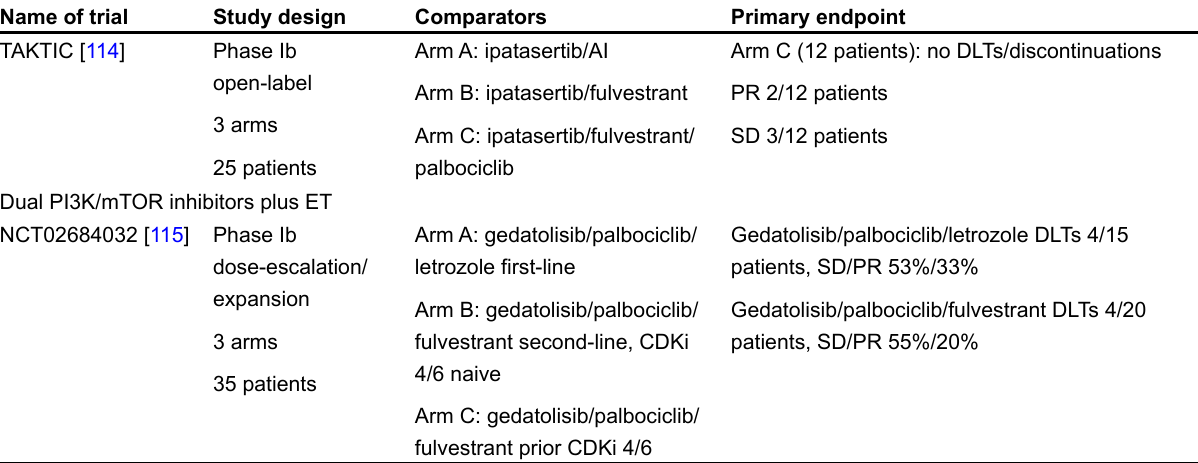
Table 1. Published clinical trials combining ET and inhibitors of the PI3K/Akt/mTOR pathway ( continued ) Name of